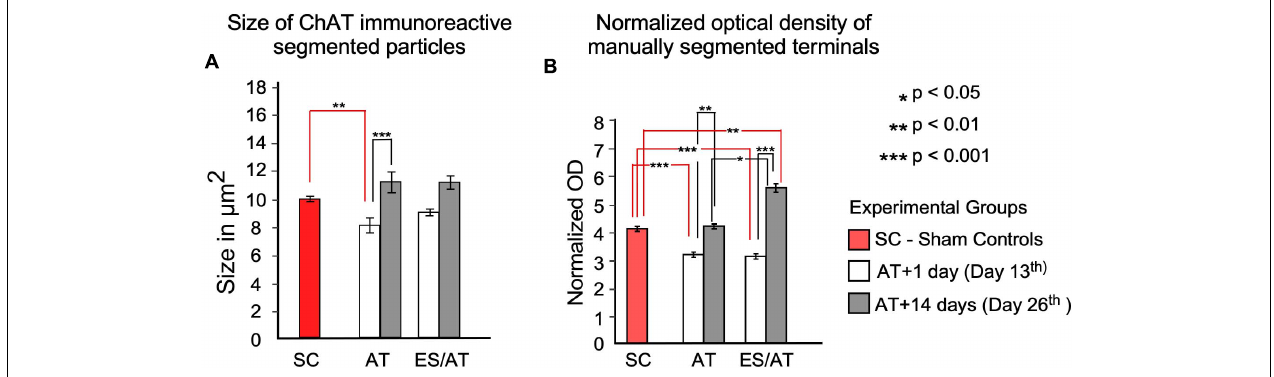
FIGURE 7 | Area and OD statistical analysis of ChAT-immunoreactive terminals through the cochlea. (A) Size of the particles. Differences were significant between the SC group and AT + 1 day (day 13) (red lines indicate this comparison). After comparing day 1 (day 13) and 14 (day 26) days after overstimulation, significant differences were identified only in the AT group (black lines). No significant differences were found after any comparison in the ES/AT group. (B) OD analysis of efferent terminals. Values are significantly lower at 1 day after overstimulation (day 13) under both experimental conditions (with or without ES). A rebound in values, significantly higher in the ES/AT group, was found at 14 days after overstimulation (day 26). * p < 0.05, ** p < 0.01, *** p <